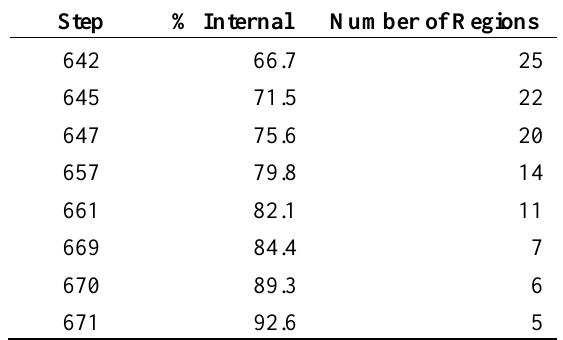
Table 5. Intramax analysis results at selected